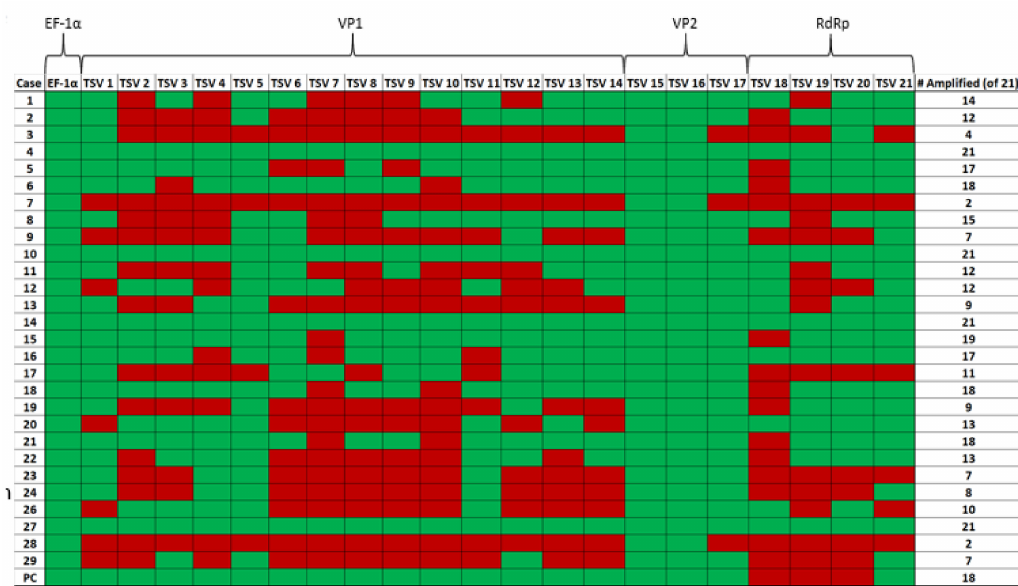
Figure 5. A pictograph of the RT-PCR amplification of TSV capsid protein VP1 and VP2 genes, RNA-dependent RNA polymerase (RdRp) and shrimp internal control gene EF-1 α . The primer pairs (TSV-1 to TSV-21) used to amplify di ff erent TSV genes are shown on the top row of the map. The case numbers are indicated in the far-left column (excluding Sample No. 25, as mentioned previously) and the total number of primer pairs (out of 21) that were successful in amplifying each sample can be seen in the far-right column. Green boxes indicate amplification and red boxes indicate no amplification for the corresponding primers.